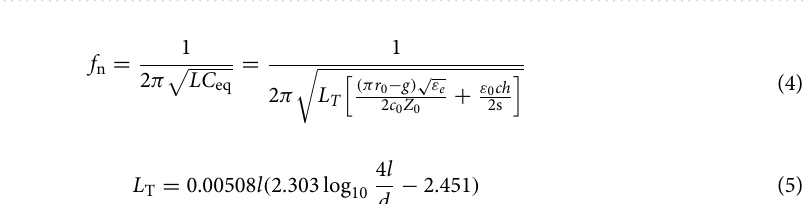
Figure 5. The VSWR characteristics of structure E, ( a ) for two different cases, ( b ) performance at C j1 variation. ( c ) The VSWR characteristics of structure F for four different cases, ( d ) performance at C j23 variation. The VSWR characteristic of structure G, ( e ) when junction capacitance of D 1 –D 3 at 2.67 pF, ( f ) when the series resistance R s vary, ( g ) performances at C j1 variation, ( h ) performances at C j23 variation and ( i ) performances at C j1 and C j23